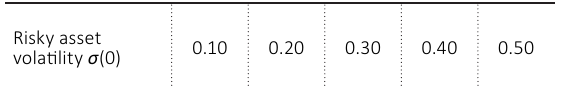
Table 1. Risky asset annual volatility level used as basis for numerical studies on American